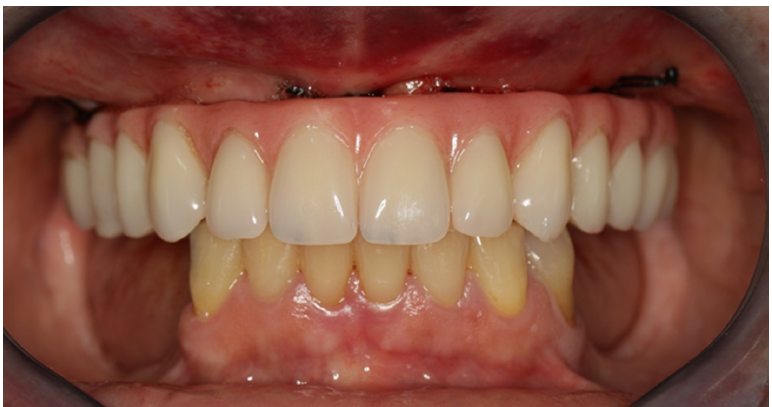
Figure 16. Intraoral frontal view perioperative photograph with the immediate prosthesis connected.